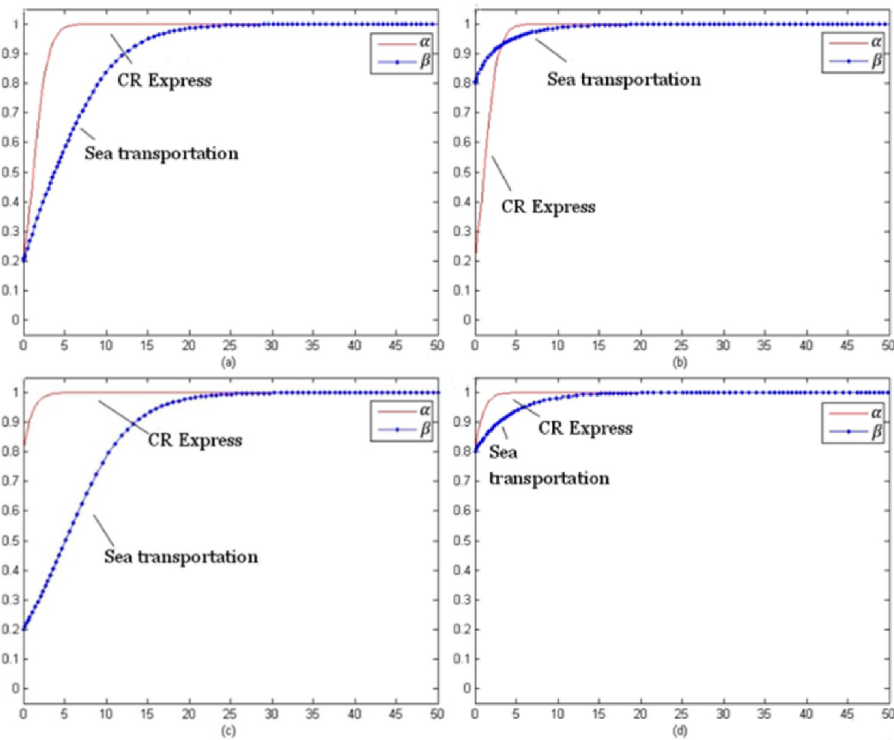
Fig 9. Game evolution trend of fruit transportation competition (without